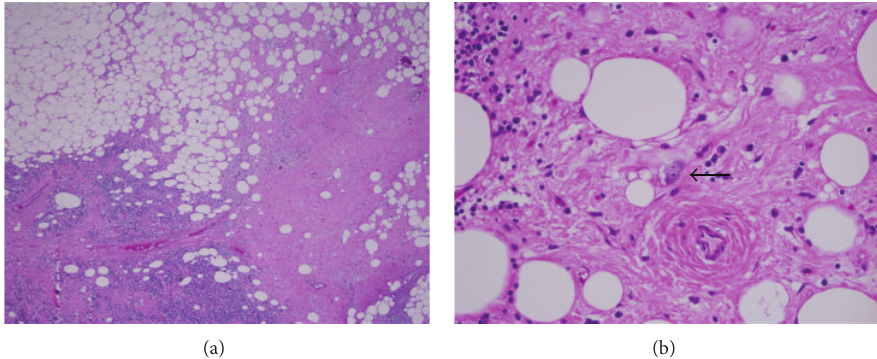
Figure 4: Photomicrograph of pathology of lipomatous retroperitoneal mass. Microscopic pathology. This is a composite photomicrograph which demonstrates representative findings from the initial surgical specimen in this case. (a) Low power representative field of the patient’s surgical specimen which demonstrates adipocytes, sclerosis, and inflammation (hematoxylin and eosin stained section, 40x magnification). (b) Lipoblasts are indicated by the black arrow and while being a common feature of liposarcomas are not necessary for diagnosis of liposarcoma (hematoxylin and eosin stained section, 400x